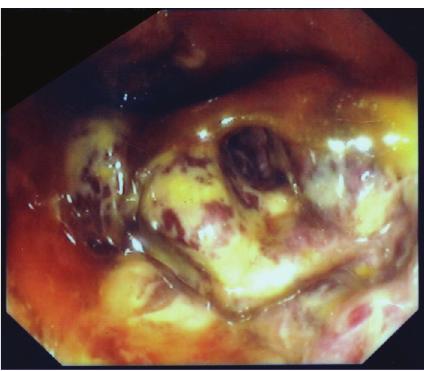
Figure 2: Two weeks after the treatment. Superficial coalescing ulcers were seen at the same site where the obstructive mass was initially